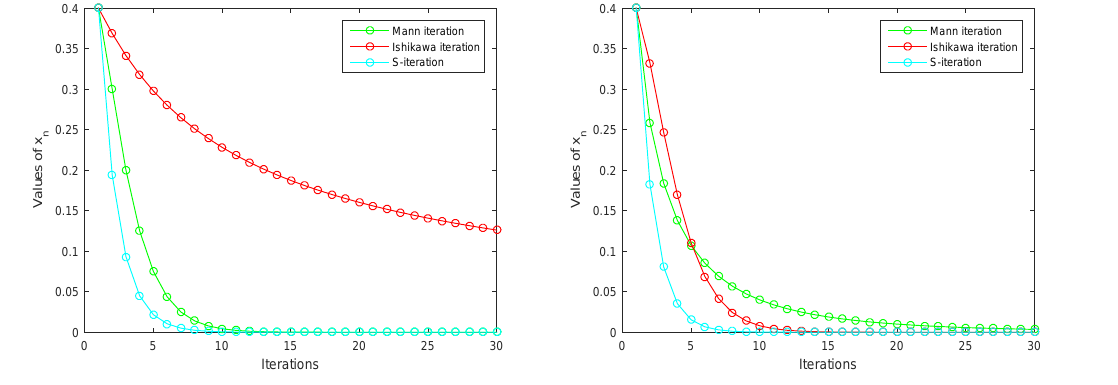
Figure 1. Comparison of Iteration Processes for different choices of parameters: α n = n β n = n (right n + 3